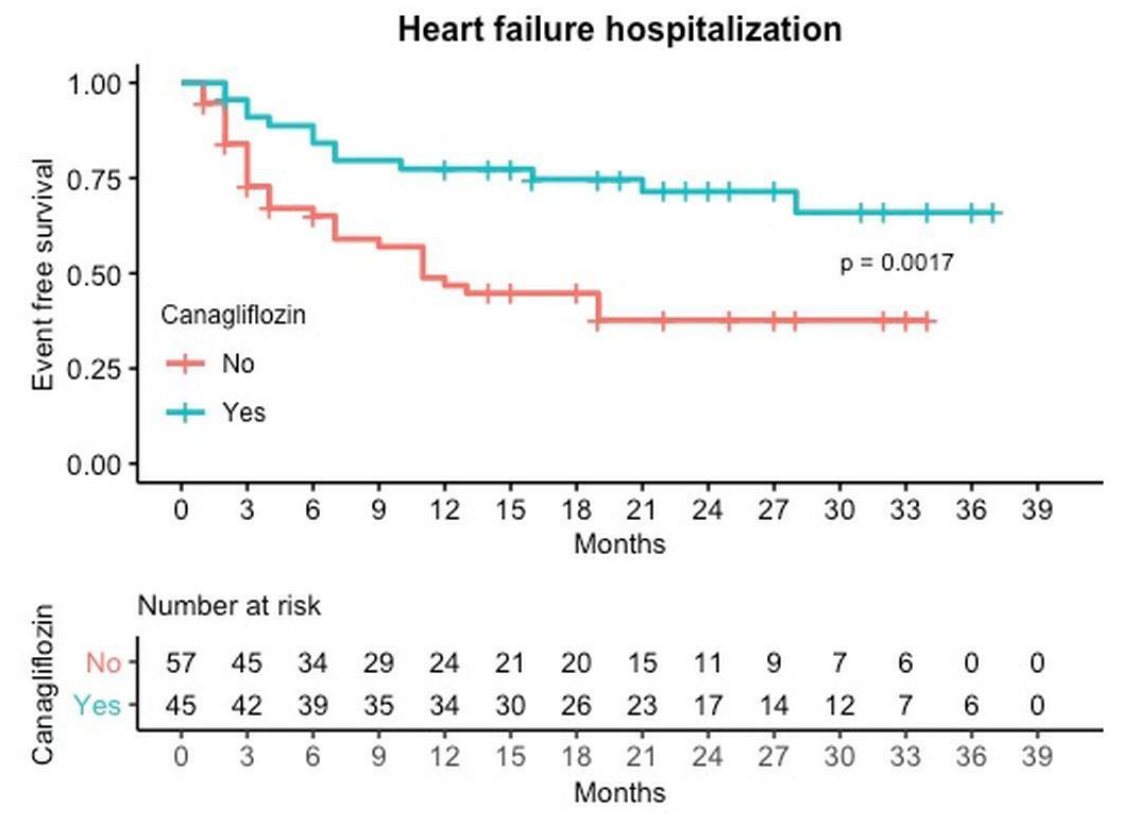
Figure 1. Event free survival curves for Readmission due to heart failure by canagliflozin treatment. The secondary composite outcome of hospitalization for HF or death from cardiovascular causes was lower in the canagliflozin group (37.8%) than in the control group (70.2%) (HR: 0.51; 95% CI: 0.27–0.95; p < 0.035) (Table 2 or Figure 2). Deaths from cardiovascular causes occurred in 9 patients (20%) in the canagliflozin group and in 23 patients (40.4%) in the control group.